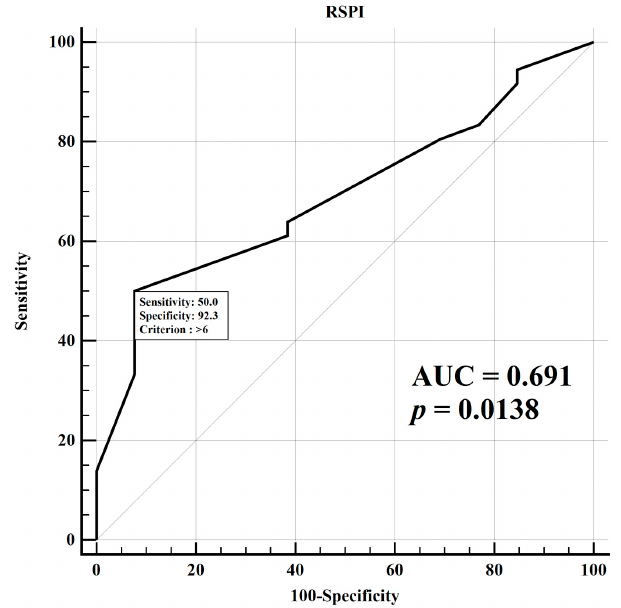
Figure 5. Receiver operating characteristic curves for Regional Strain Pattern Index (RSPI) in prediction of Cardiac Resynchronization Therapy (CRT) response (AUC = area under the curve). Table 3. Dyssynchrony indexes: univariate logistic regression analysis for CRT response. Univariate Logistic Regression Analysis (Responder: ∆ LVESV ≥ 15%) Odds Ratio [OR]; 95% Confidence Interval. (‘ p ’